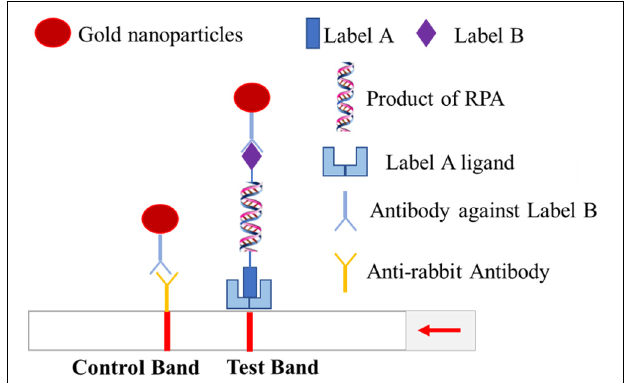
FIGURE 1 | Schematic of RPA-LFD